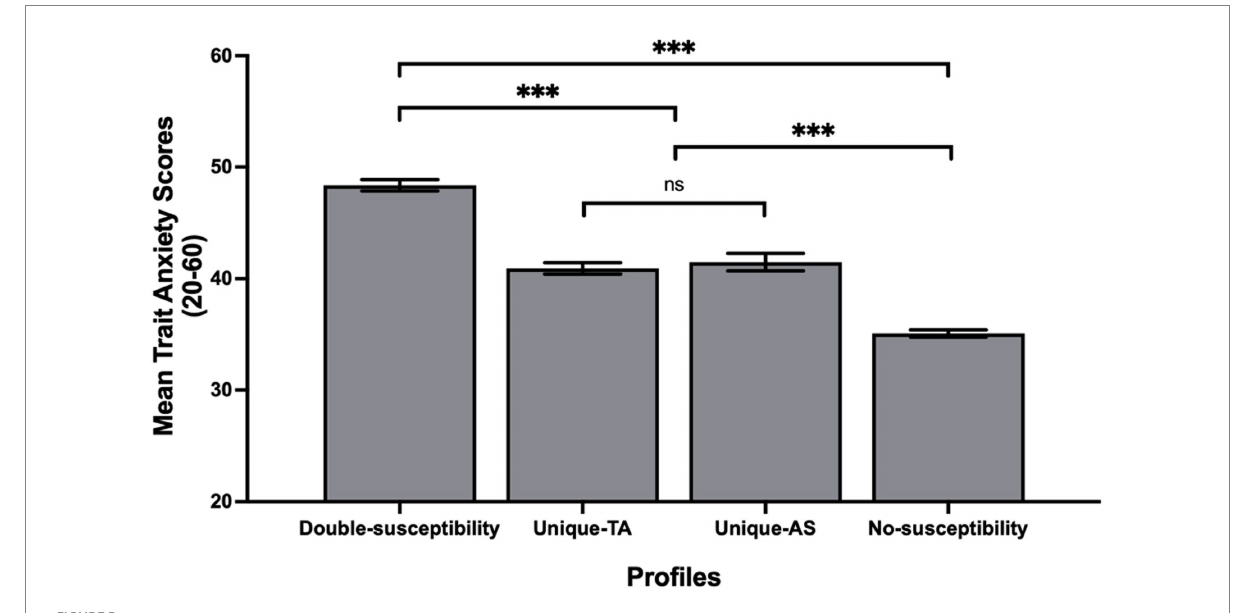
FIGURE 5 Levels of trait anxiety as a function of students’ latent profile. * p <